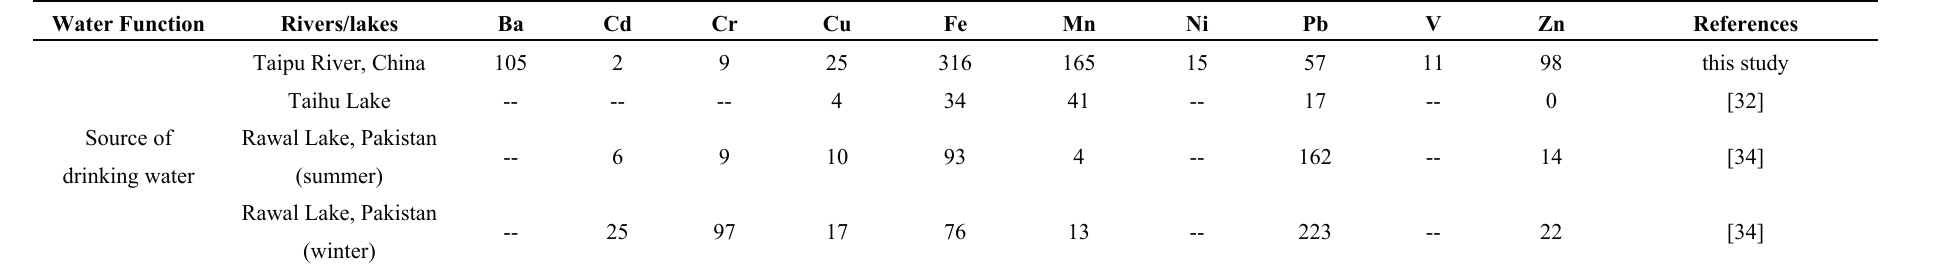
Abbreviations: Avg. in the table denotes the average value. T.R. denotes Taipu River. W.R. denotes Wusong River. DS denotes the dry season. ER denotes the early rainy season. LR denotes the late rainy season. Table 2. Comparison of the average heavy metal concentrations found in this study with concentrations found in other water bodies and with international water quality guidelines; units: ug/L. Water